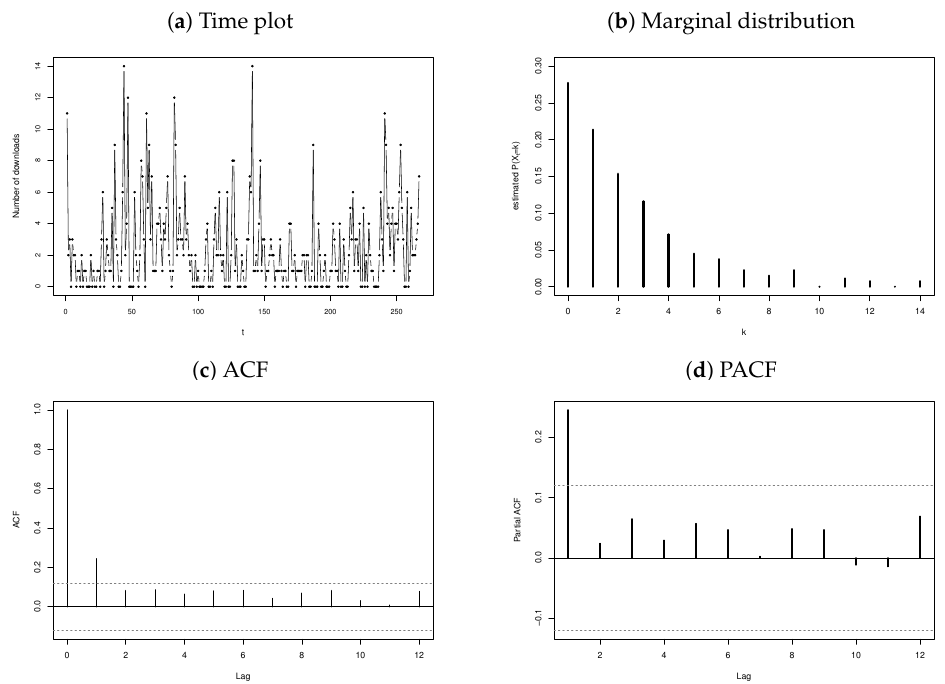
Figure 8. Time plot, observed marginal distribution, ACF, and PACF for the download data.